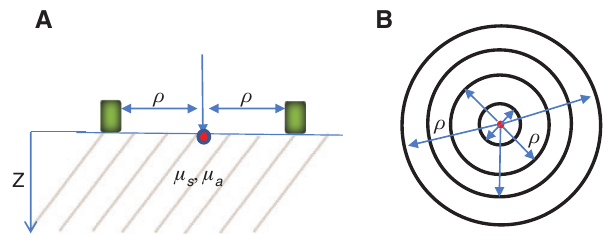
Figure 1: A schematic description of the diffusion